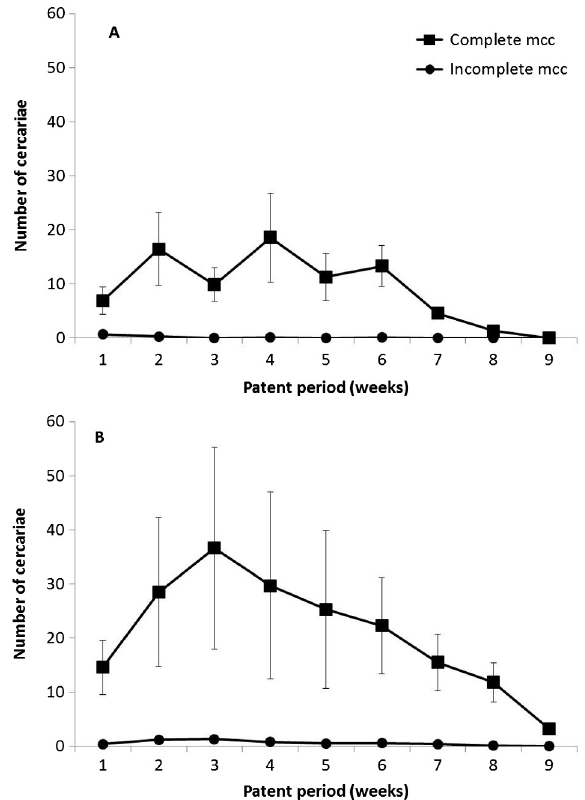
Figure 2. Distribution of P. daubneyi metacercariae (mcc) for controls (A) and temperature-challenged snails (B) correlated to length of patent period (expressed in weeks). The values noted for controls from both snail populations were pooled. A similar process was also used for values coming from temperature-challenged snails.